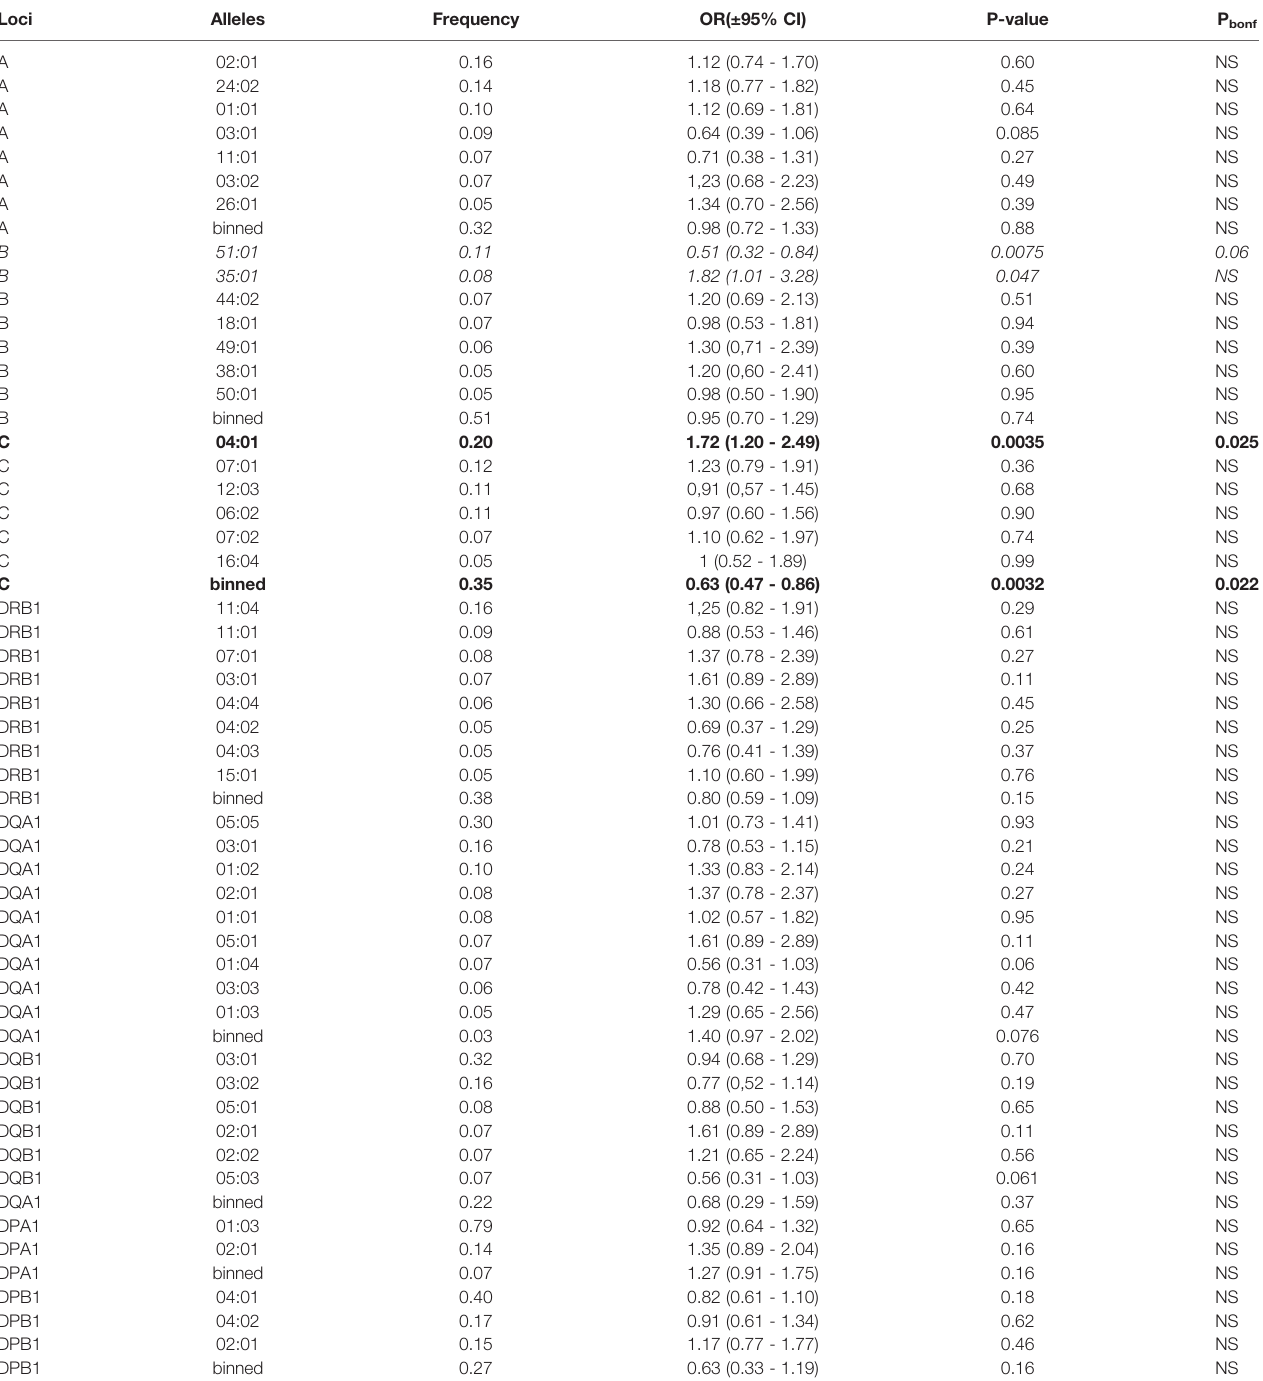
TABLE 2 | Unconditional ordinal logistic regressions for the association of the genotypes of each common allele (freq > 0.05%) of the HLA class I and class II loci with the disease severity characteristics in the additive model of each common allele. Loci Alleles Frequency OR(±95% CI)